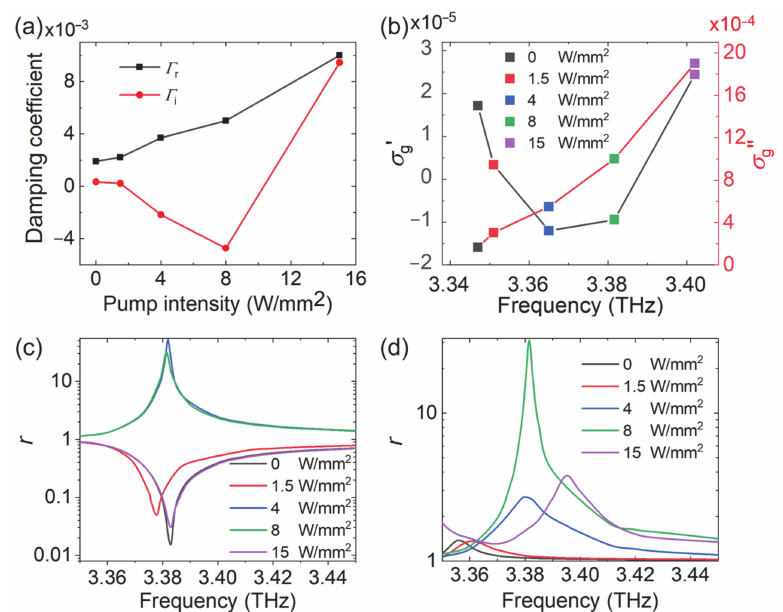
Figure 8. ( a ) The radiation loss Γ r and intrinsic losses Γ i as a function of pump intensity. ( b ) The conductivity of graphene as a function of pump intensity at di ff erent resonance frequencies. Reflection amplitude with di ff erent optical pump intensity when the ( c ) imaginary part of conductivity is fixed as 0.001 S and the ( d ) real part of conductivity is fixed as − 9.42 µ S. The conductivity of graphene is − 9.42 + 1000 i µ S at 3.38 THz when I = 8 W / mm 2